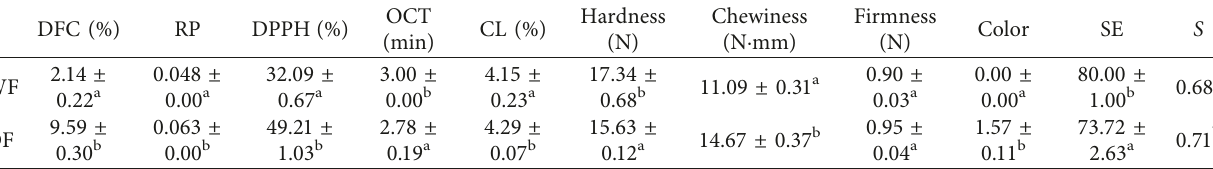
Table 3: Comparison of the qualities of wheat flour (dumpling wrapper) and optimized flour (dumpling wrapper) 1 . DFC (%) RP DPPH